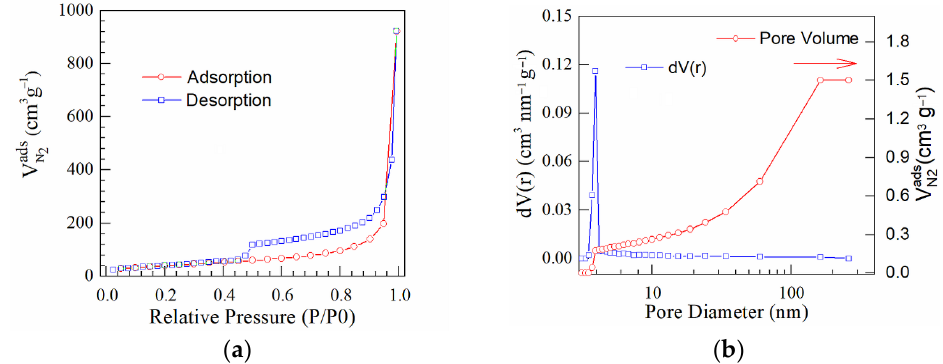
Figure 7. ( a ) N 2 adsorption–desorption isotherms; and ( b ) BJH curves corresponding to N/GO_A.